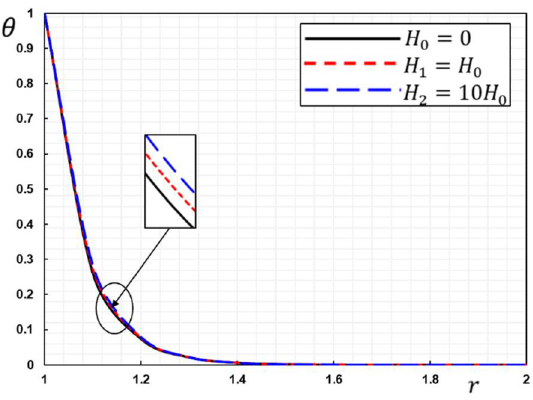
Figure 2. The temperature change, θ , versus the axial magnetic field, H 0 . The variation in temperature c across the radial distance is shown in Figure 2. The temperature changes are initially of larger magnitudes and become smaller over time to